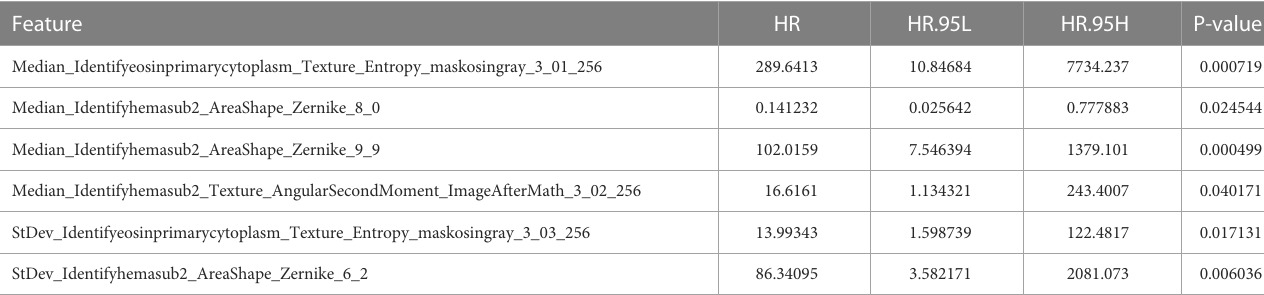
TABLE 2 The key information of the prognostically signi fi cant morphological features in the multivariate cox regression.